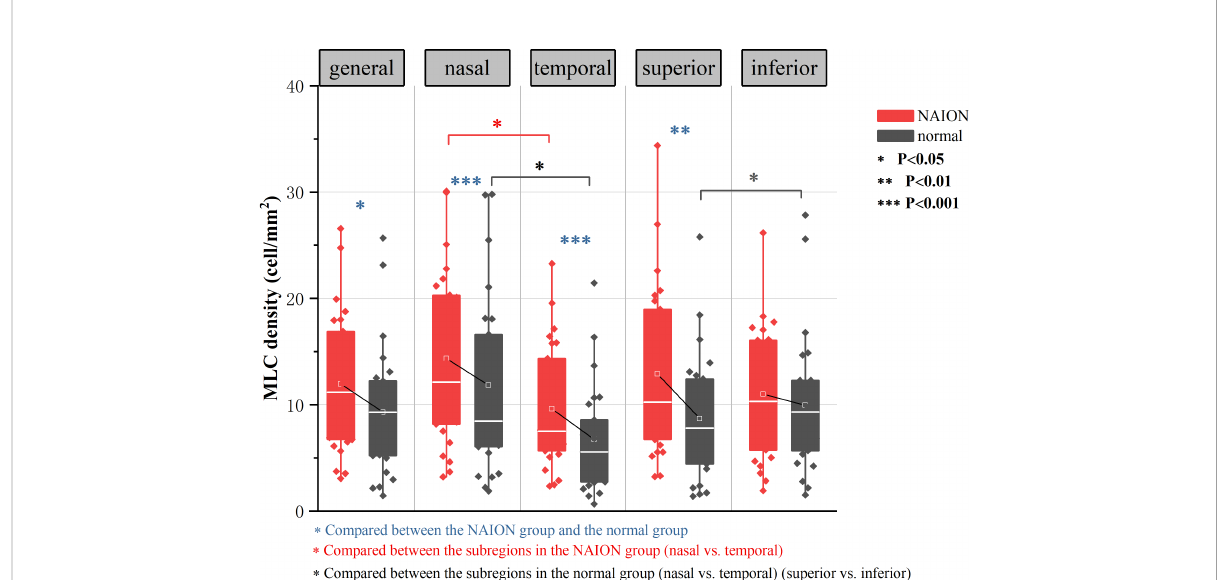
FIGURE 3 Result of two-ways repeated measures ANOVA in analyzing the effect of diasease and subregions in MLC density. Both the NAION group and the control group showed signi fi cantly increased MLC density in the nasal region than in the temporal region (p=0.026). In normal group, there were more MLCs in the inferior than in the superior (p=0.021). MLC density was higher in the NAION group (p=0.028), In horizontal sector analysis, MLC density increased in NAION eyes especially in the superior (p=0.008) when compared to the inferior subregion (p=0.315). In